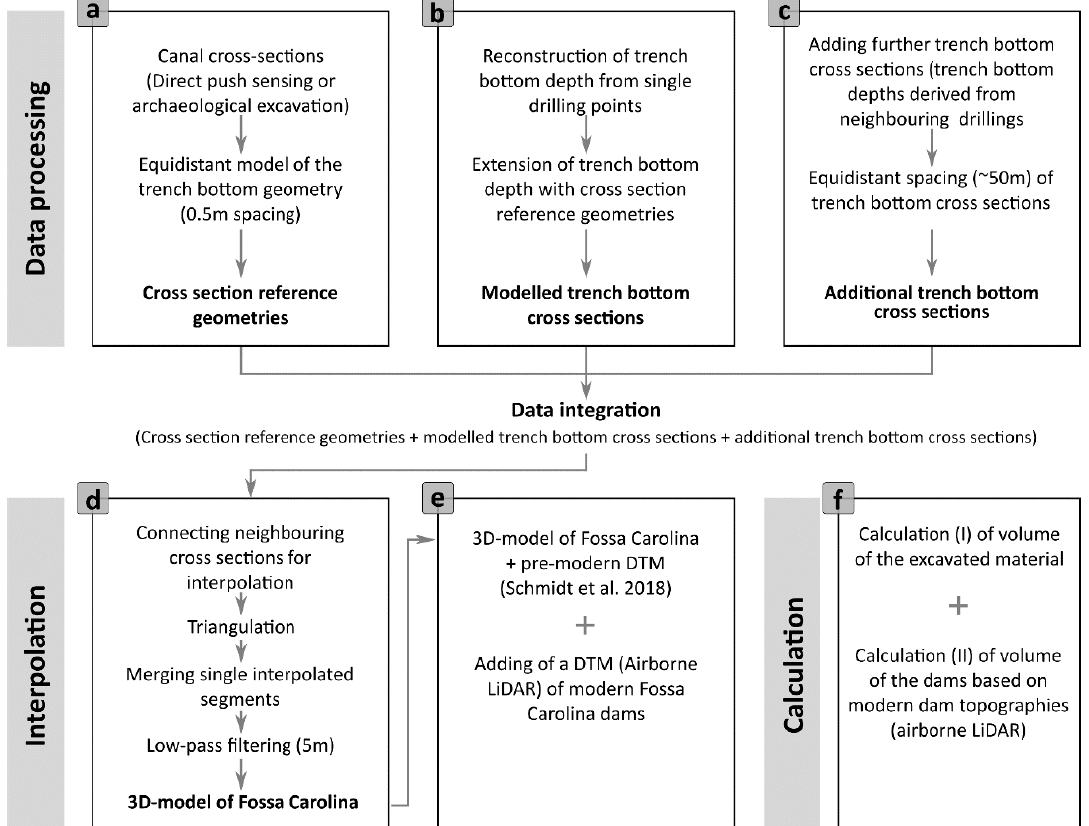
Figure 4: Flow chart of the modelling approach and subsequent calculation of volumes. a ) Creation Figure 4. Flow chart of the modelling approach and subsequent calculation of volumes. ( a ) Creation of cross-section reference geometries, b ) Modelling of trench bottom cross-section geometries, c ) of cross-section reference geometries, ( b ) Modelling of trench bottom cross-section geometries, Equidistant spacing of trench bottom cross-sections, d ) 3D-model of the Fossa Carolina trench ( c ) Equidistant spacing of trench bottom cross-sections, ( d ) 3D-model of the Fossa Carolina trench bottom, e ) 3D-model of the Fossa Carolina and the surrounding pre-modern topography, f ) bottom, ( e ) 3D-model of the Fossa Carolina and the surrounding pre-modern topography, ( f ) Calculation Calculation of the volume of the excavated material and of the volume of the present dams. of the volume of the excavated material and of the volume of the present